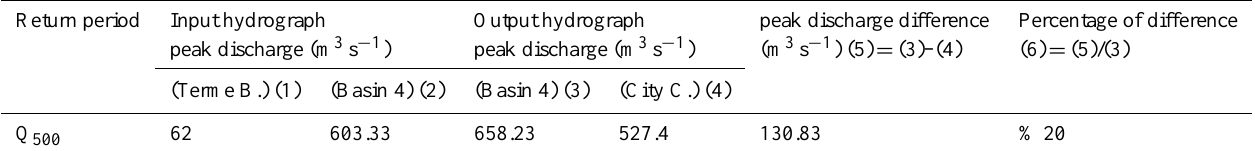
Table 5. Scenario4 model results.